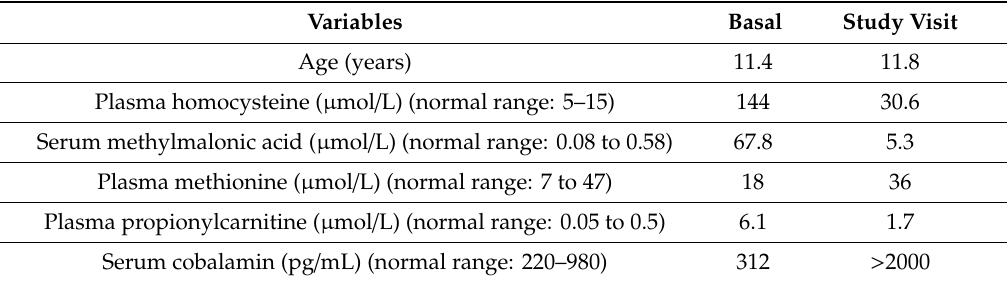
Table 1. Biochemical parameters at the diagnosis time before the treatment initiation (basal) and at the study